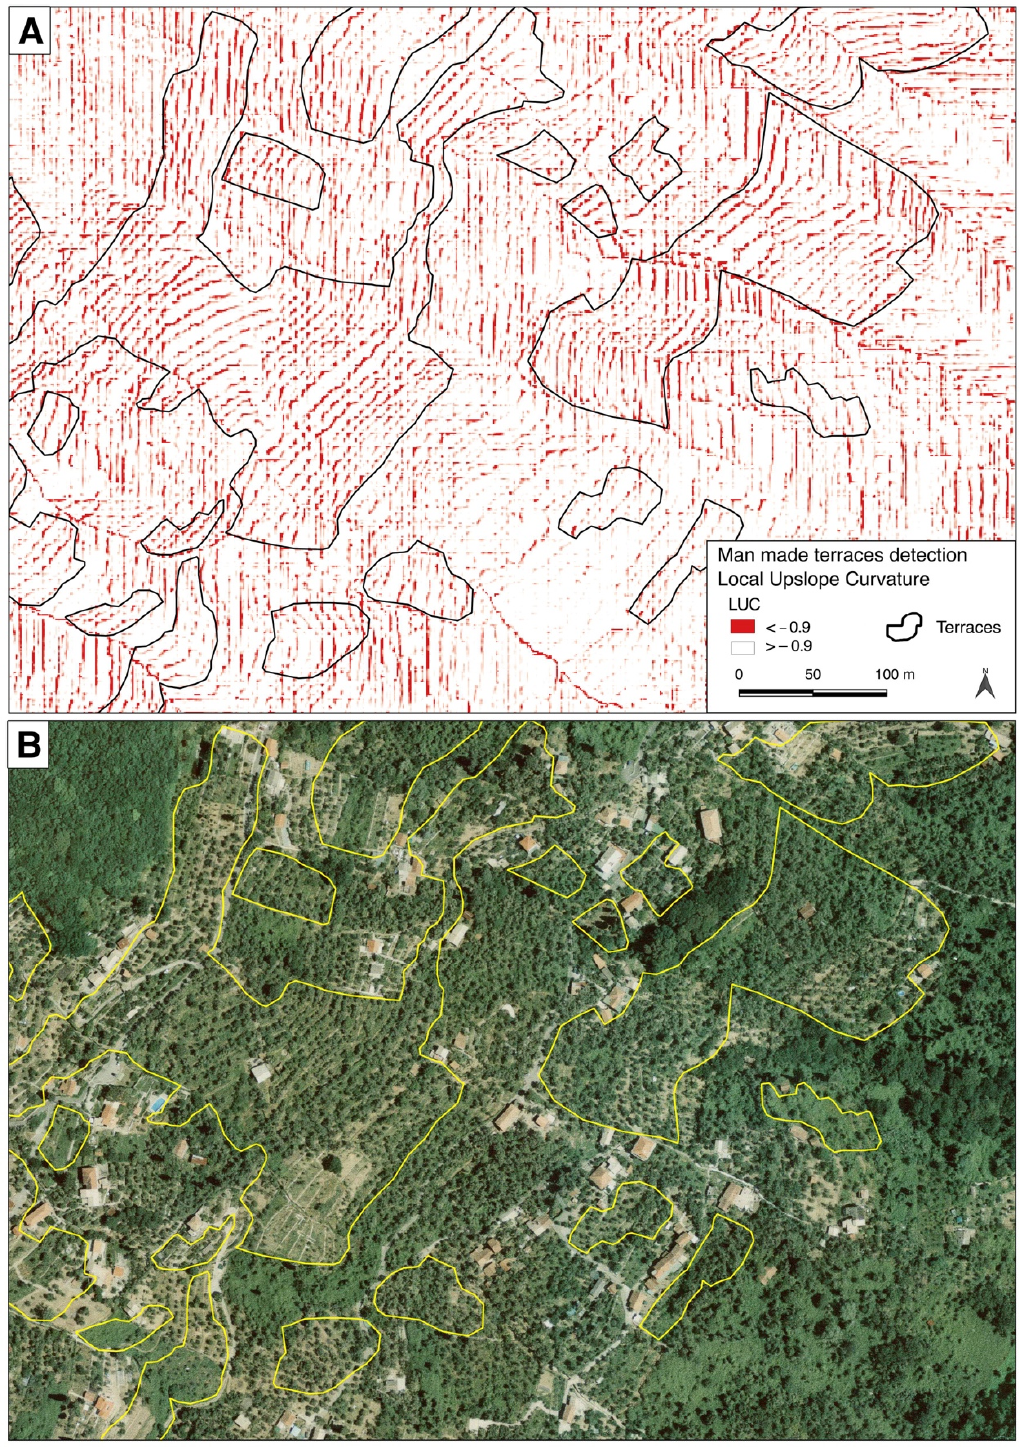
Figure 4. Terrace identification test. ( A ): stone wall basis identification through Local Upslope Curvature (LUC) after proper enhancement. ( B ): aerial orthophotography of the area with, in yellow, the terraced areas identified through LUC calculation.